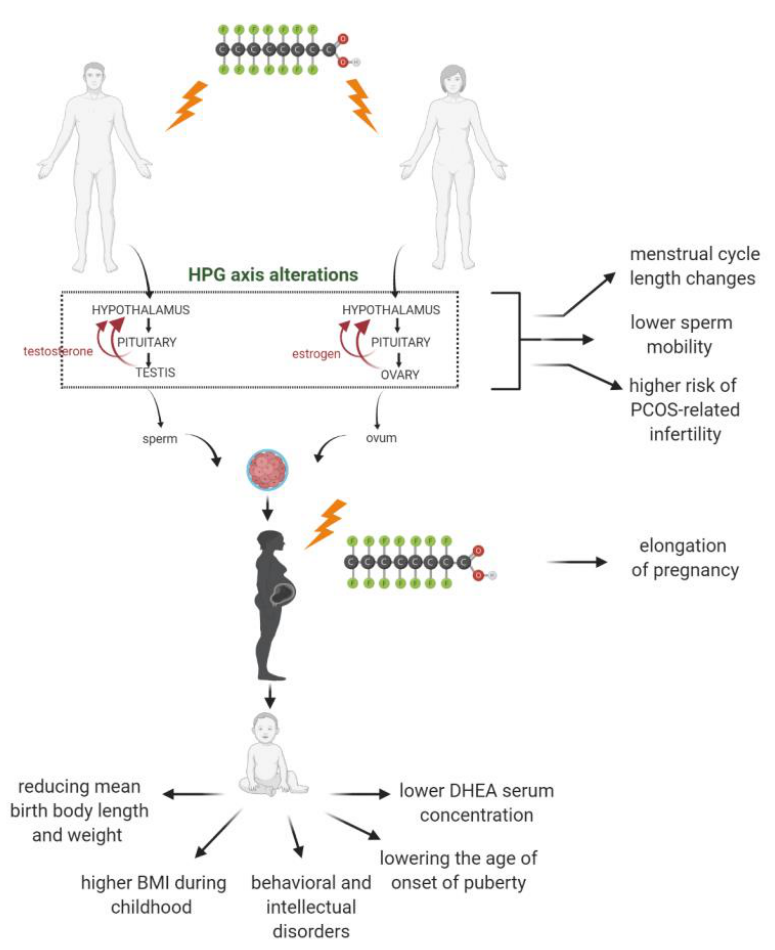
Figure 2. Alterations in hypothalamic–pituitary–gonadal axis functions with potential health effects caused by per- and polyfluoroalkyl substances (PFASs) exposure [32,44,46,151,152,153,154].